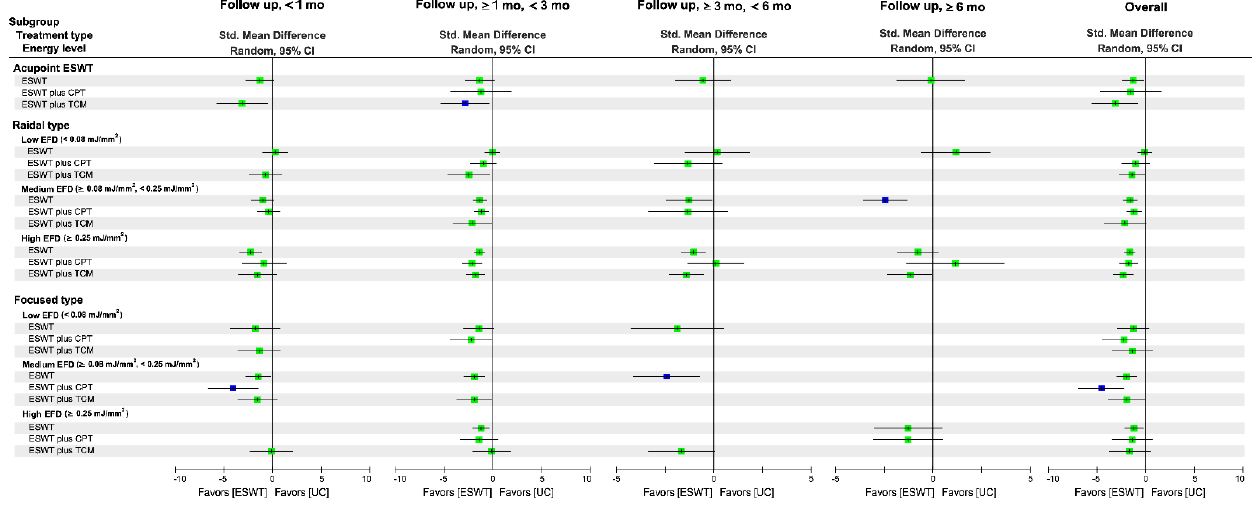
Figure 2. Network plot of the direct comparisons of different treatments for ( A ) pain, ( B ) global function, and ( C ) disease inflammation. The lines between nodes indicate direct comparisons in various studies. The size of each node is proportional to the number of the participants. The thickness of each line is proportional to the number of studies denoted on the line. FoSW, focused shockwave; RaSW, radial shockwave; HI, high energy; MI, medium energy; LI, low energy; CPT, conventional physical therapy; TCM, traditional Chinese medicine; UC, usual care.